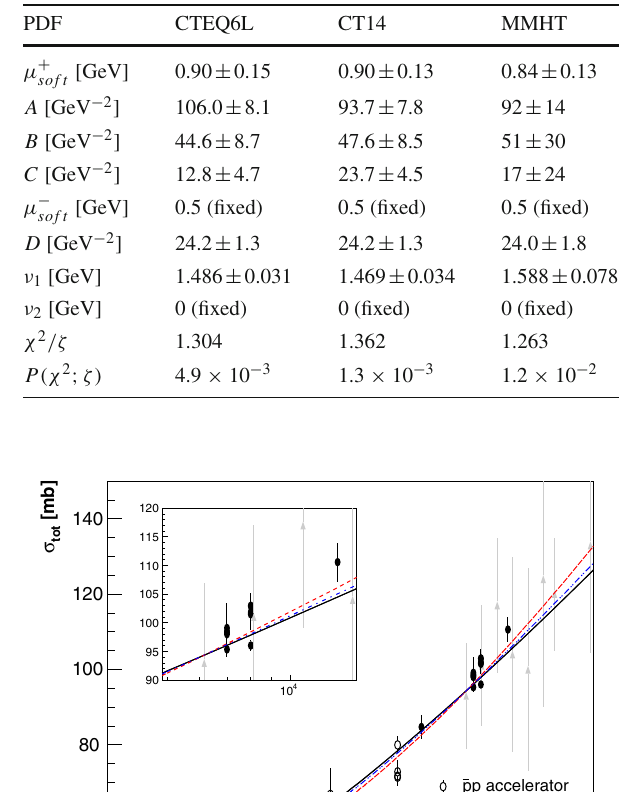
Table 5 Best-fit parameters of our model, obtained by fixing ν 2 = 0, with ζ = 168 degrees of freedom